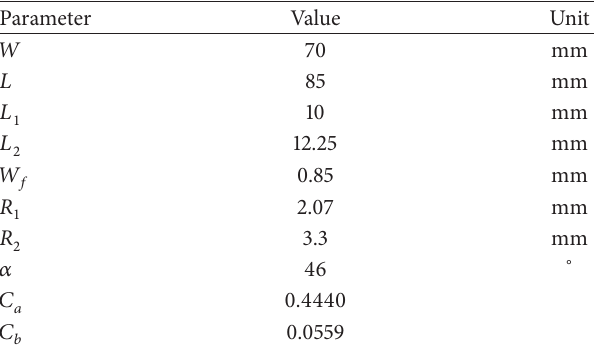
Table 1: Geometrical parameters of the original Vivaldi antenna.